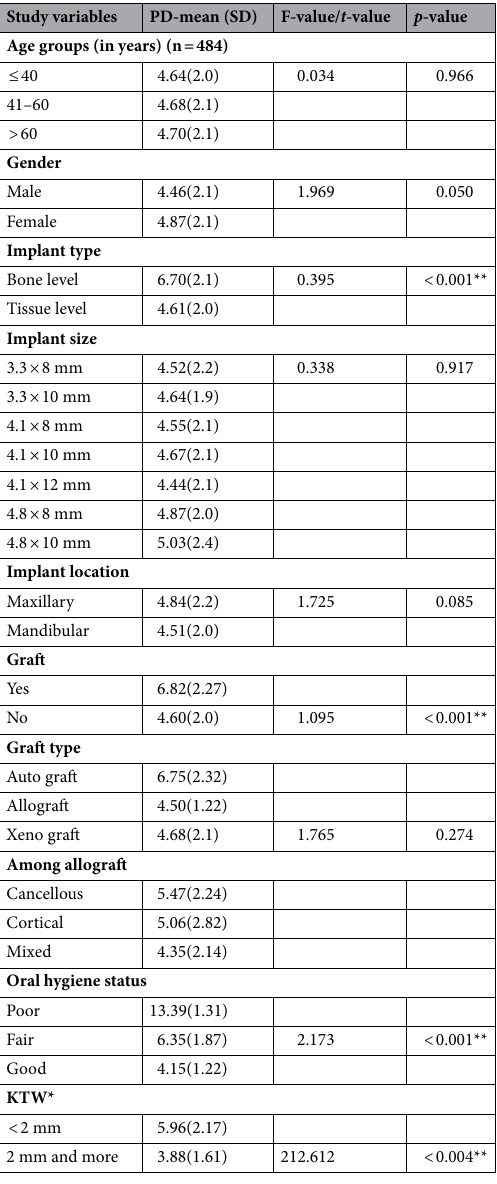
Table 1. Comparison of mean values of PPD in relation to the study variables. *Keratinized tissue width. **Statistically